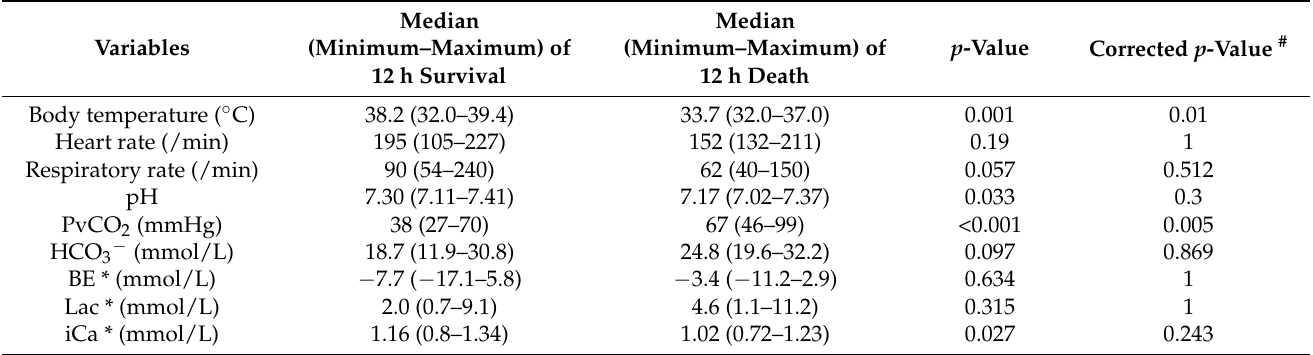
Table 2. Comparison of clinical data and blood gas analysis of cats diagnosed with cardiogenic pulmonary edema.